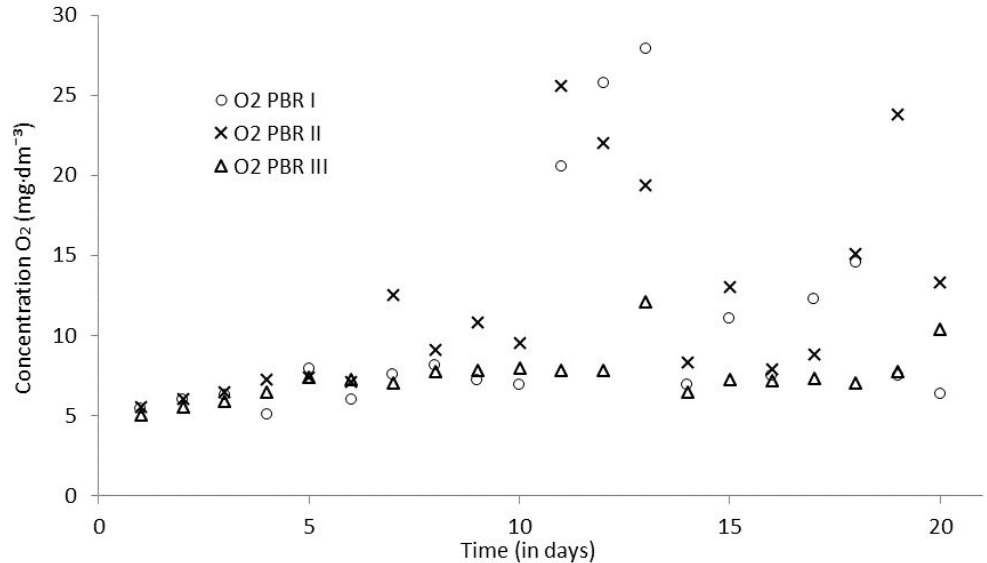
Figure 4. The distribution of oxygen over time, depending on the type of illumination system. Source: own study.